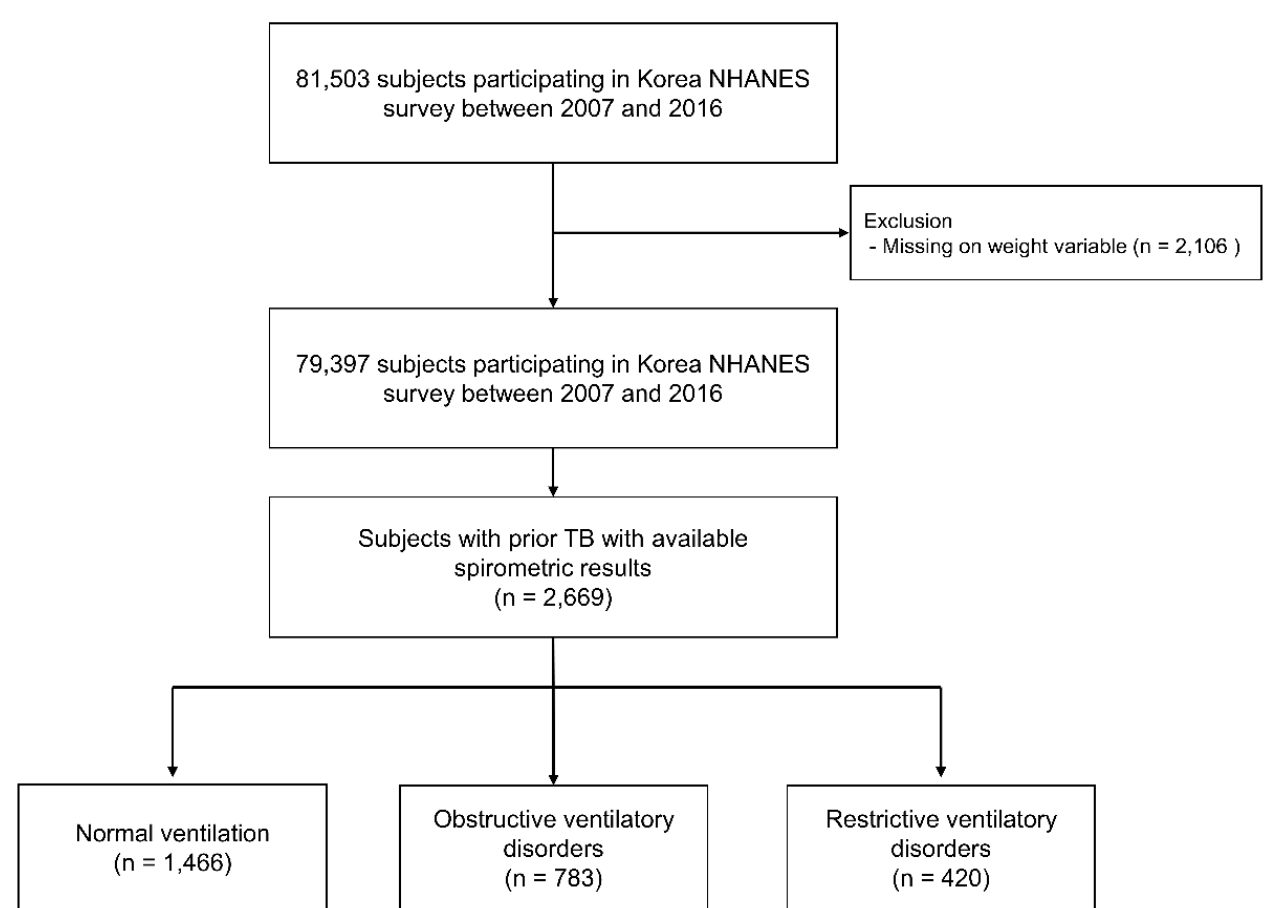
Figure 1. Flow chart of patient selection. TB, Tuberculosis; NHANES, National Health and Nutrition Examination Survey.